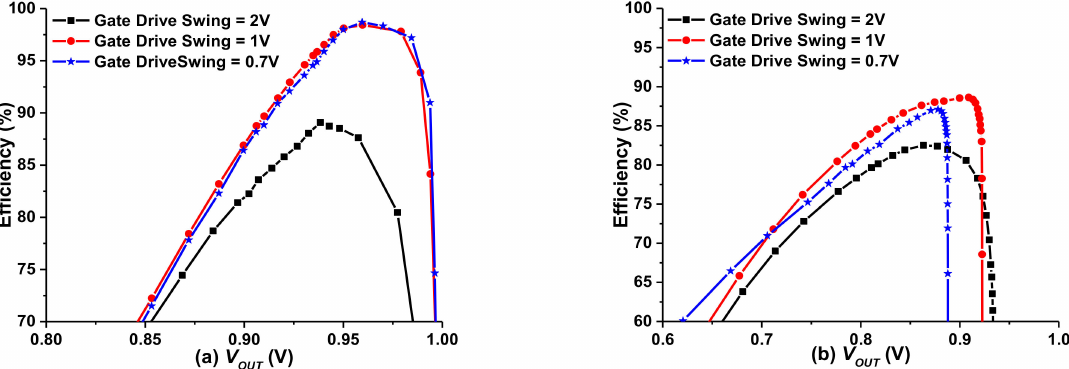
Figure 5. Effect of gate drive voltage swing variation V IN = 2.0 V ( a ) Light load (500 nA). ( b ) Heavy load (100 µ